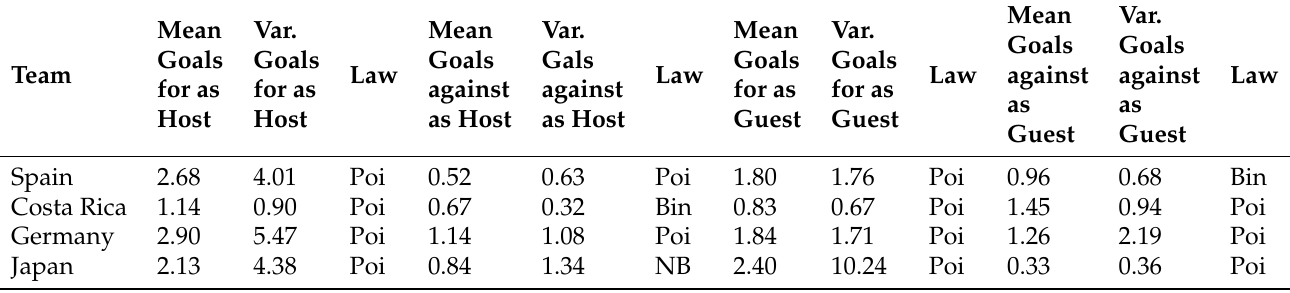
Table 23. Group E in Qatar